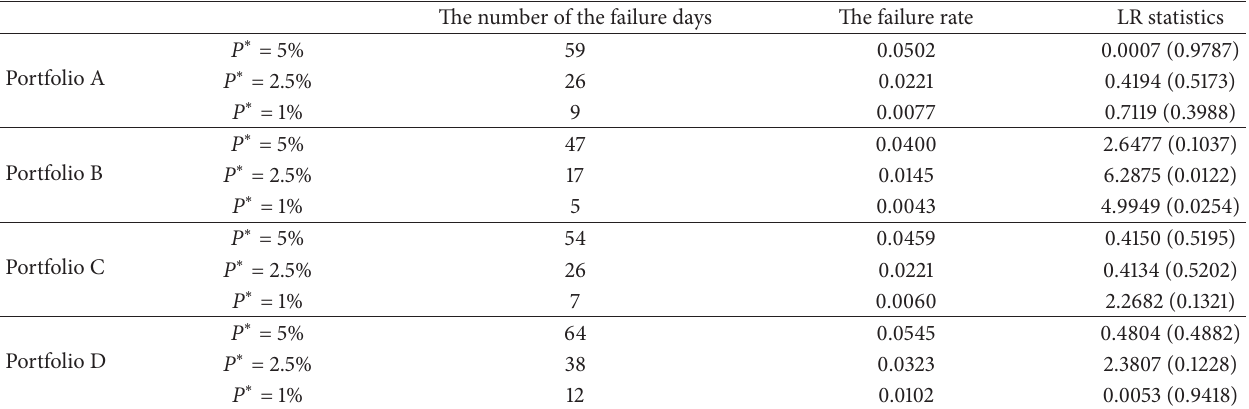
Table 5: The results of the Kupiec test for the PSRM method.